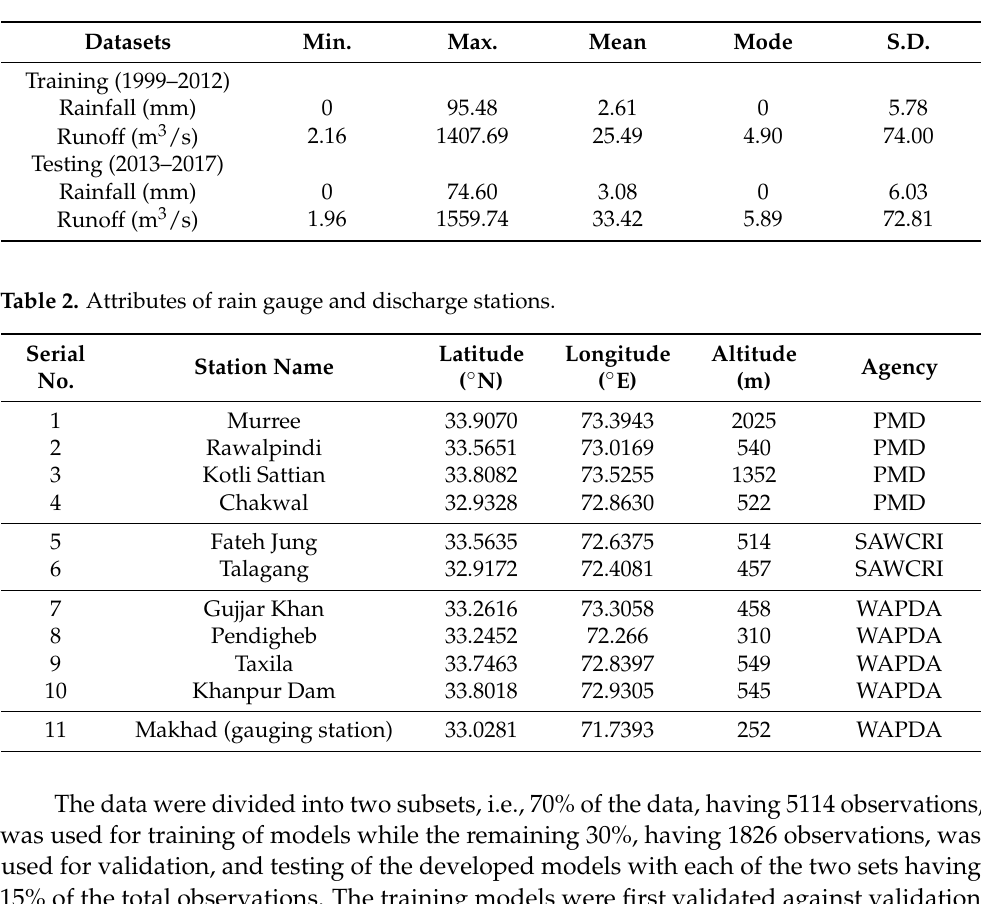
Table 1. Statistical characteristics of datasets.